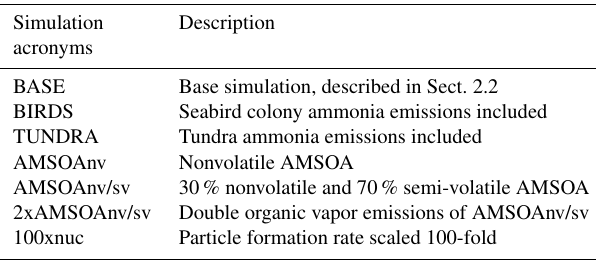
Table 1. Description of acronyms that are used in the simulation names. Simulations are described in more detail by full simulation name in Sect.